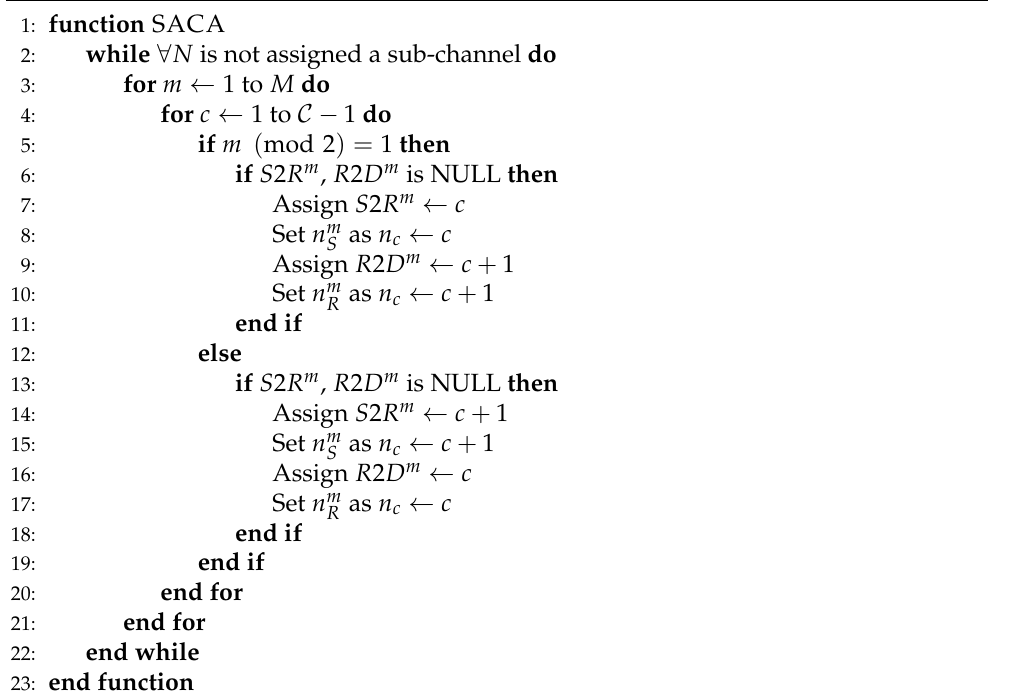
Algorithm 4 SR Alternating Channel Allocation